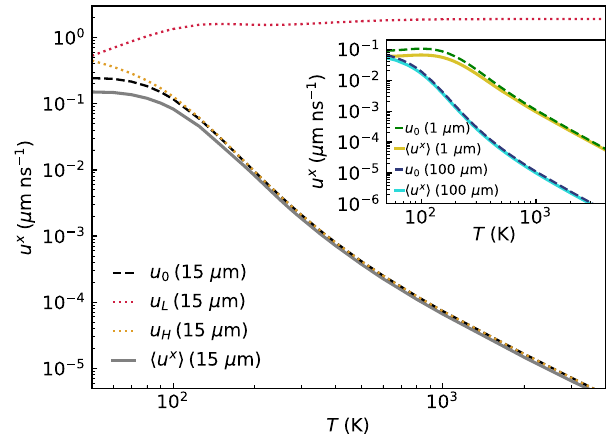
FIG. 10. Estimates of the characteristic value of the drift velocity u 0 (dashed lines) as combination of the asymptotic trends given by u [Eq. (H3), dotted orange line] and u H L [Eq. (H6), dotted red line] for graphite samples having total 15 μ m (main plot), 1 and 100 μ m l l length l L þ R ¼ TOT ¼ (inset). h u x i (solid lines) is the average value of the drift velocity computed from the numerical solution of the viscous heat < x < ð l l equations in the region l L L þ R Þ